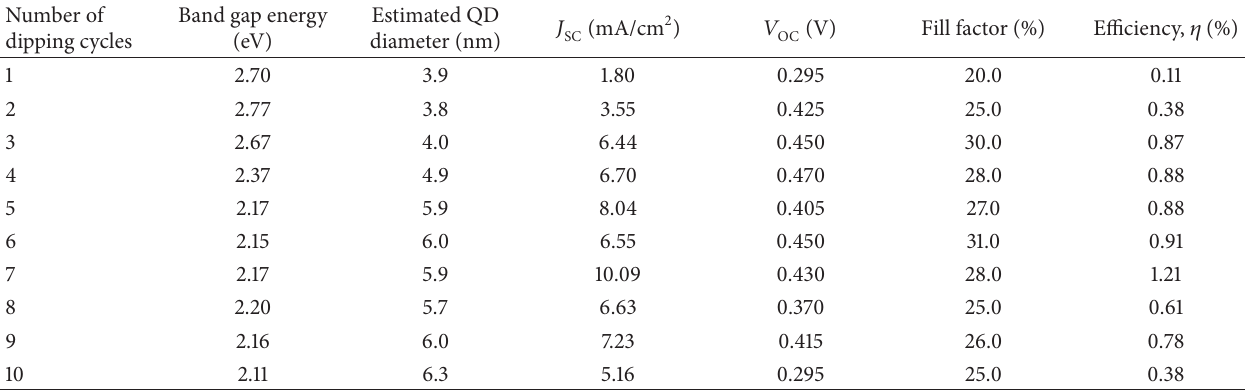
Table 4: The energy gap and size of QDs and QDSSC performance parameters for CdSe QDs prepared using different number of dipping